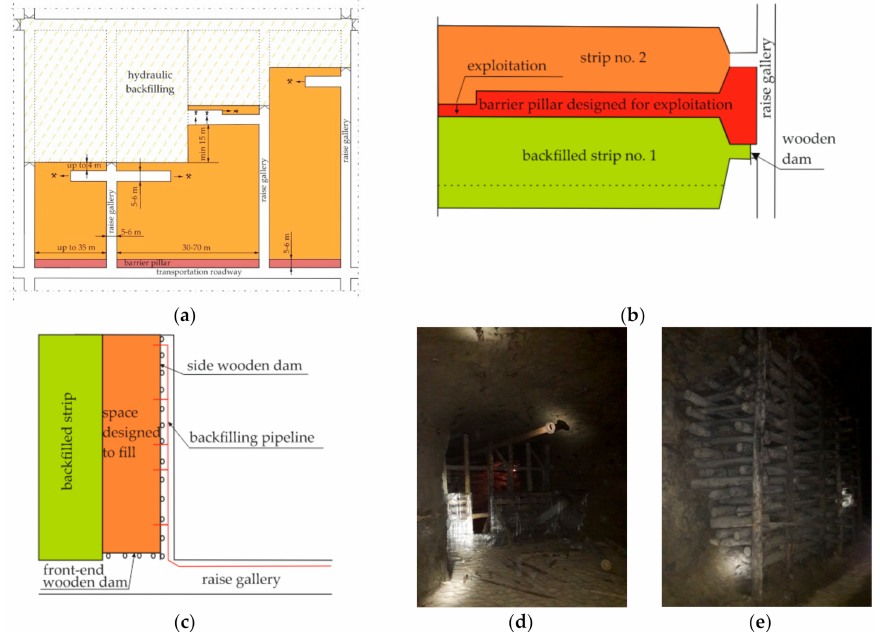
Figure 3. Strip mining method in Olkusz-Pomorzany mine: ( a ) Unidirectional and bidirectional exploitation; ( b ) Exploitation with a barrier pillar; ( c ) Exploitation without a barrier